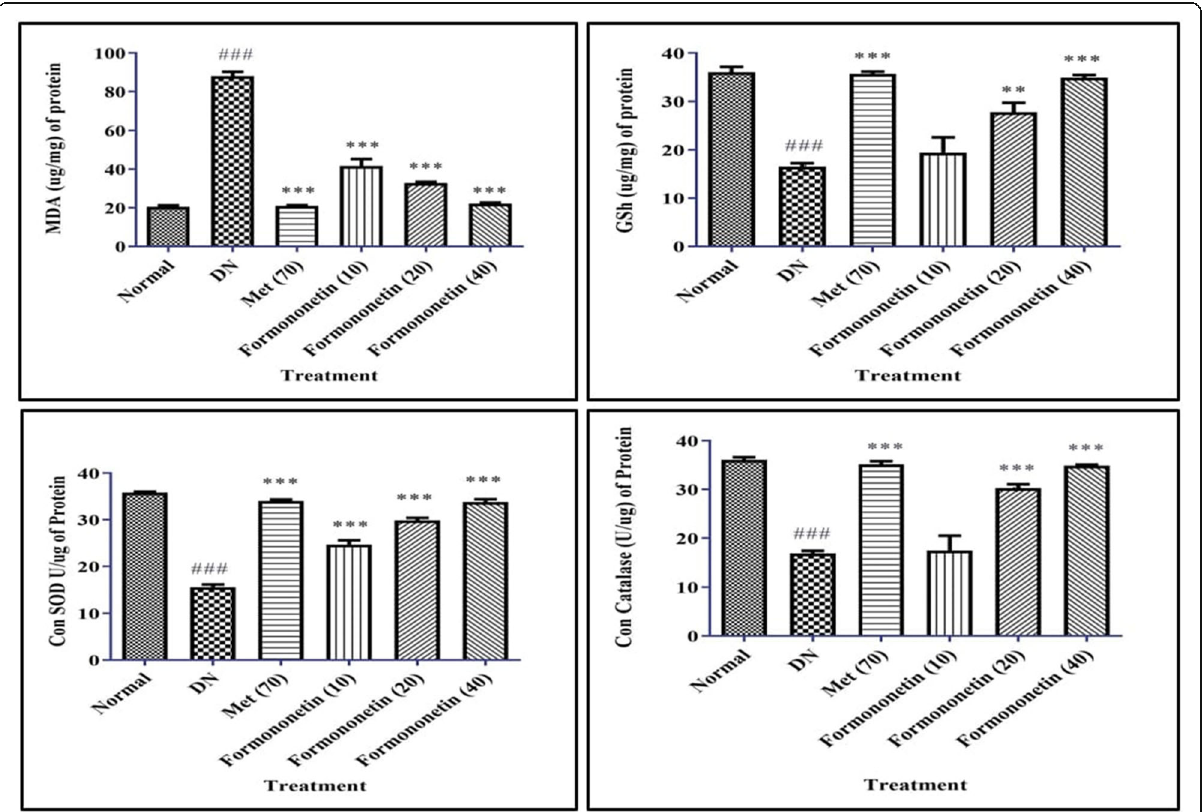
Fig. 4 Effect of STZ and formononetin on oxidative stress in kidney tissue homogenate. Data were presented as mean ± S.E.M. (n-6). The result values were statistically analyzed by using one-way ANOVA followed by Bonferroni ’ s test for multiple